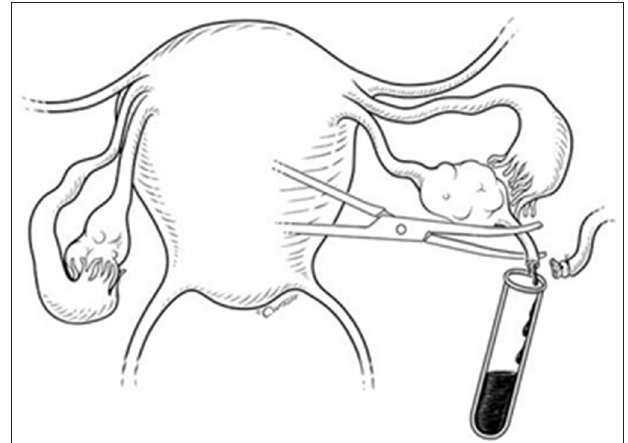
FIGURE 1 | Ovarian blood sampling technique during total abdominal hysterectomy and bilateral salpingo-oophorectomy. Reproduced from Fogle RH, Stanczyk FZ, Zhang X, Paulson RJ. Ovarian androgen production in postmenopausal women. J Clin Endocrinol Metab. 2007; 92:3040–3, with permission of the Endocrine